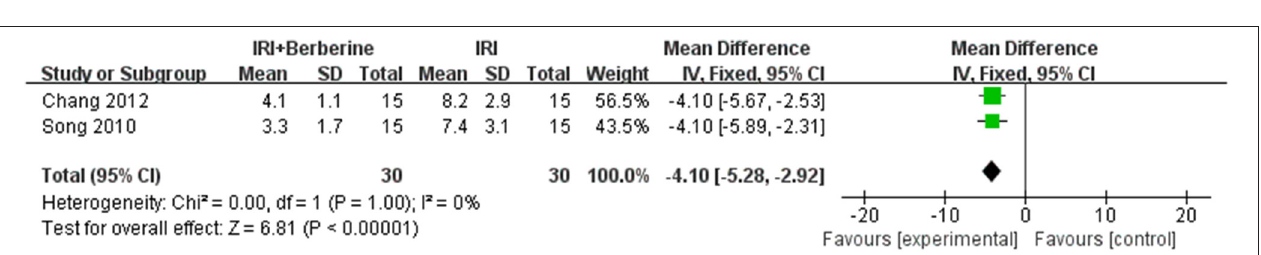
FIGURE 8 | Forest plot showing the effects of BBR on decreasing the cumulative duration of ventricular tachycardia compared to the control group.